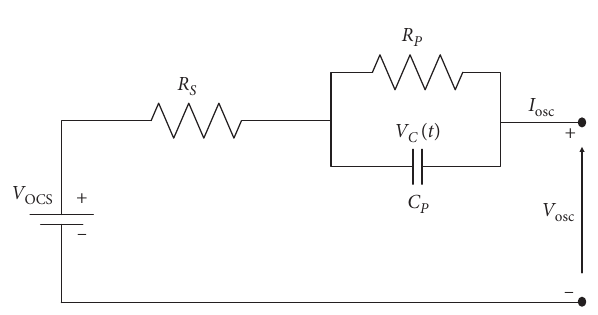
Figure 13: Simple supercapacitor topology.